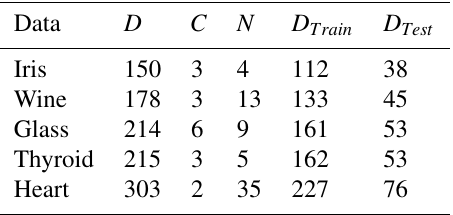
Table 8. Properties of the date